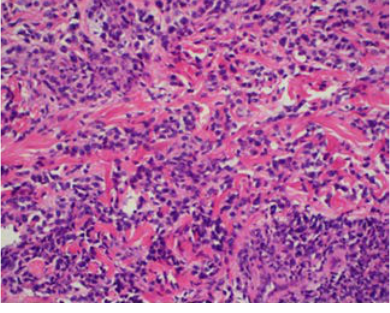
Figure 2. Left hip biopsy showing a diffuse interstitial infiltrate of large atypical lym- phoid cells displaying pleomorphic fea- tures with mitotic figures.